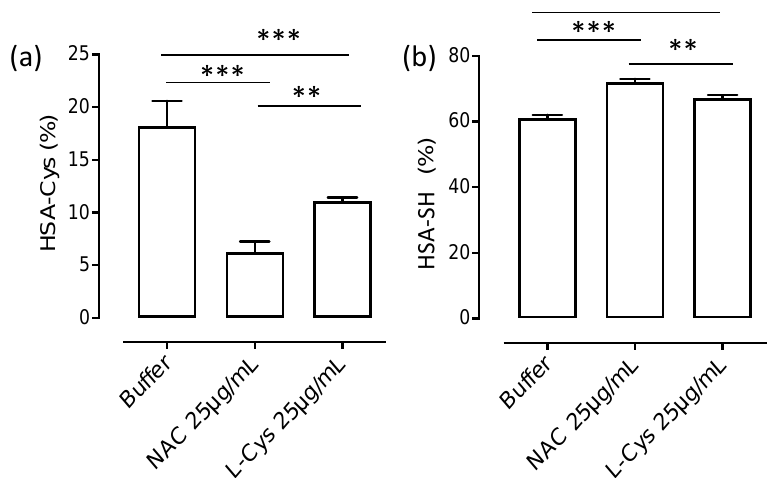
Figure 5. Comparative analysis of NAC and Cys in breaking HSA-Cys ( a ) and restoring HSA-SH ( b ). NAC and Cys were incubated with human plasma for 60 min at 37 ◦ C. Significant di ff erences are indicated by * p < 0.001 and ** p < 0.001; ANOVA